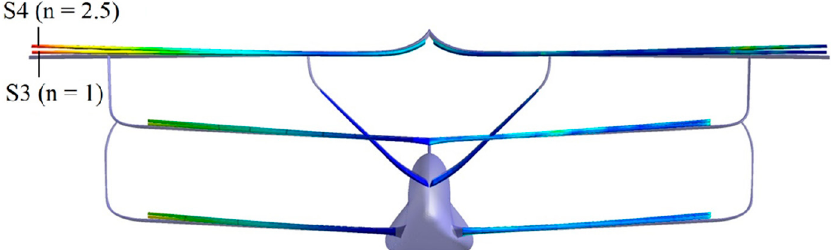
Figure 24. BWA/SL aircraft in flight conditions S 3 and S 4 (M = 0.7 at 43,000 ft and sea level, respec- tively) with an angle-of-attack α = 0°. Deflections ( left ) and stress ( right ) exerted by the aircraft planform.